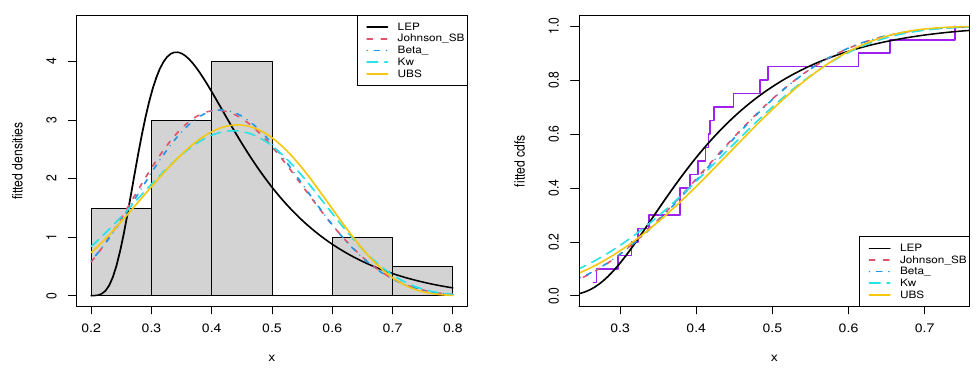
Figure 16. Estimated pdfs ( left ) and cdfs ( right ) for the application models.